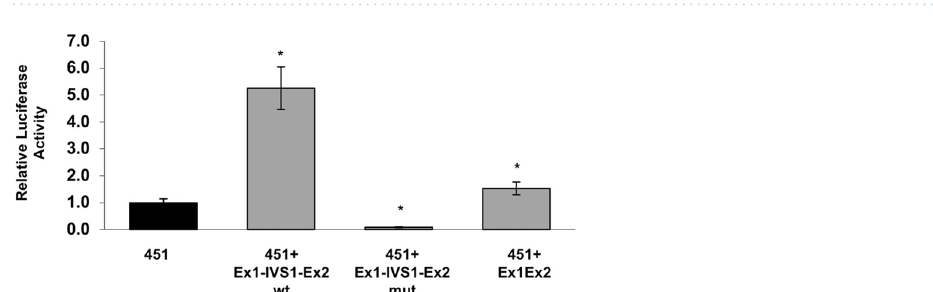
Figure 9. Effects of 5 ′ UTR and intron 1 on the luciferase activity of the TARDBP promoter constructs. The luciferase activity of 5 ′ UTR TDP-43 constructs depicted in Fig. 8A was assayed by transient cotransfections (luciferase and renilla) in SH-SY5Y cells. After 48 h, cells were assayed for firefly luciferase expression (normalized against renilla). The empty expression vector was tested and produced background levels of luciferase activity (data not shown). Data are mean (± SD) of three independent assays. Significance values refer to comparisons against control transfections (451): *p < 0.05 (one way ANOVA with Tukey